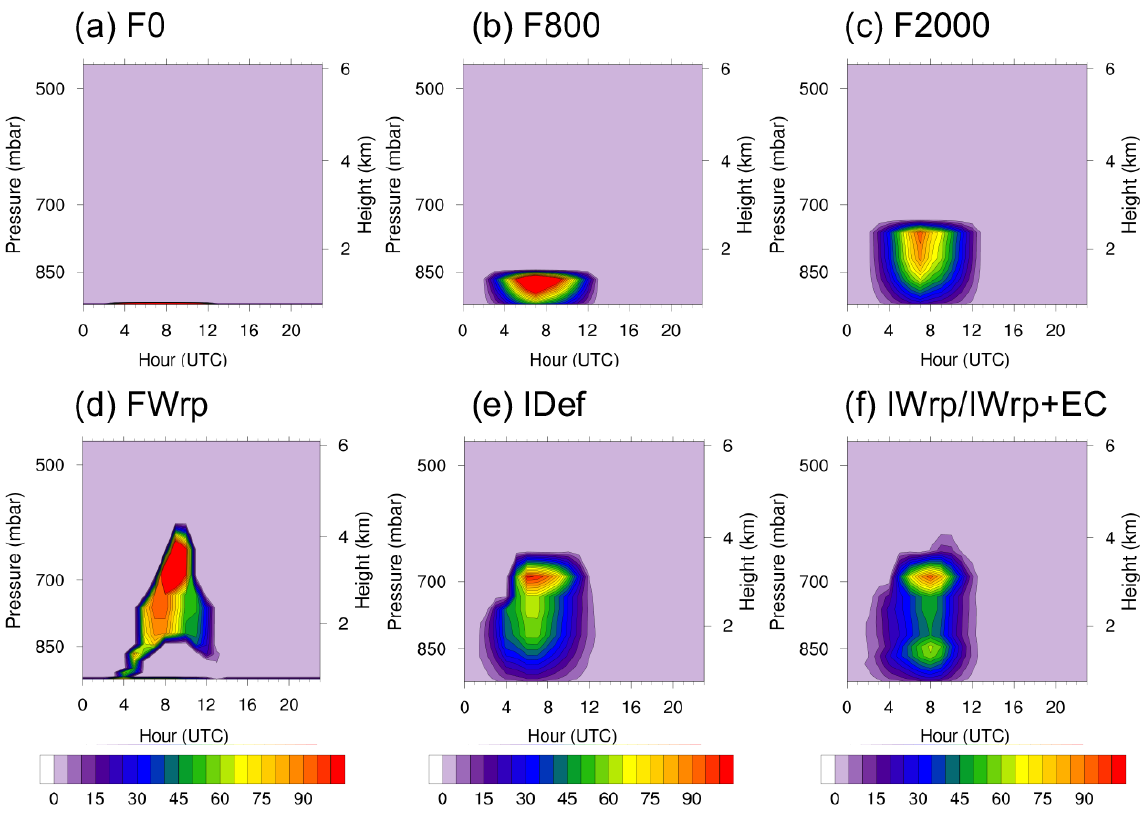
Figure 2. Initial CO emission rate (mols − 1 ) profile at Mae Hong Son, Thailand, on 13 March 2013 (UTC) for each case setup in Table 2 with (a) F0, (b) F800, (c) F2000, (d) FWrp, (e) IDef and (f) IWrp/IWrp +